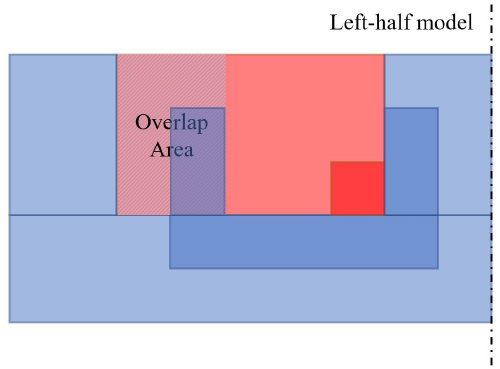
Figure 8. Example of the overlap